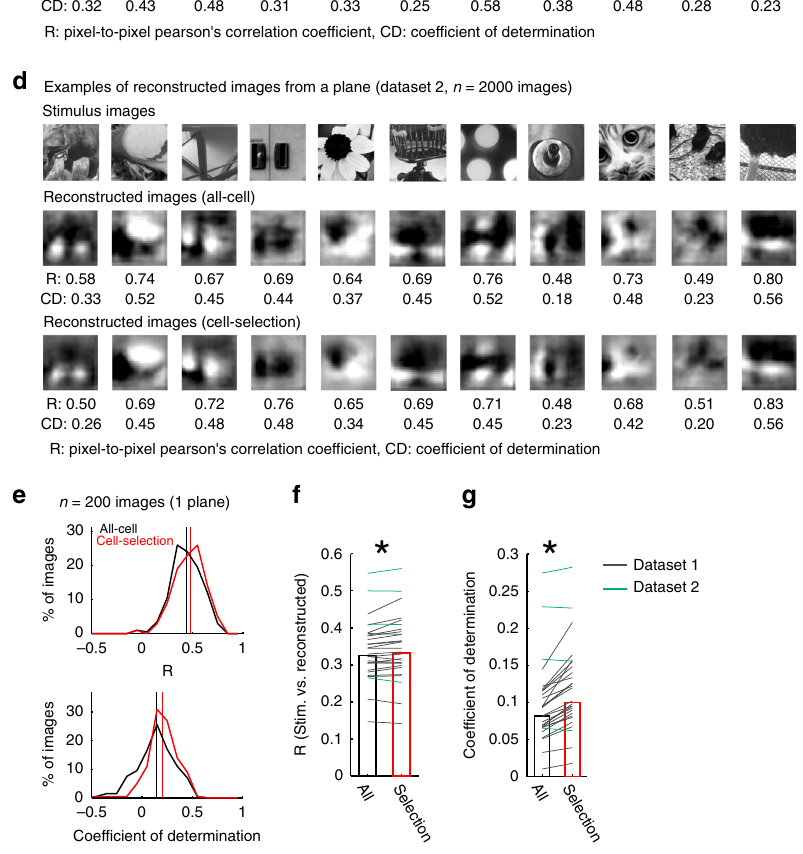
optimal performances (Supplementary Fig. 5a – c). Thus, the cell- selection model captures nearly optimal feature-cell assignment for the reconstruction. V1 neurons mainly represented low SF components of natural images. Reconstructions of lower SF components (0.02 and 0.04